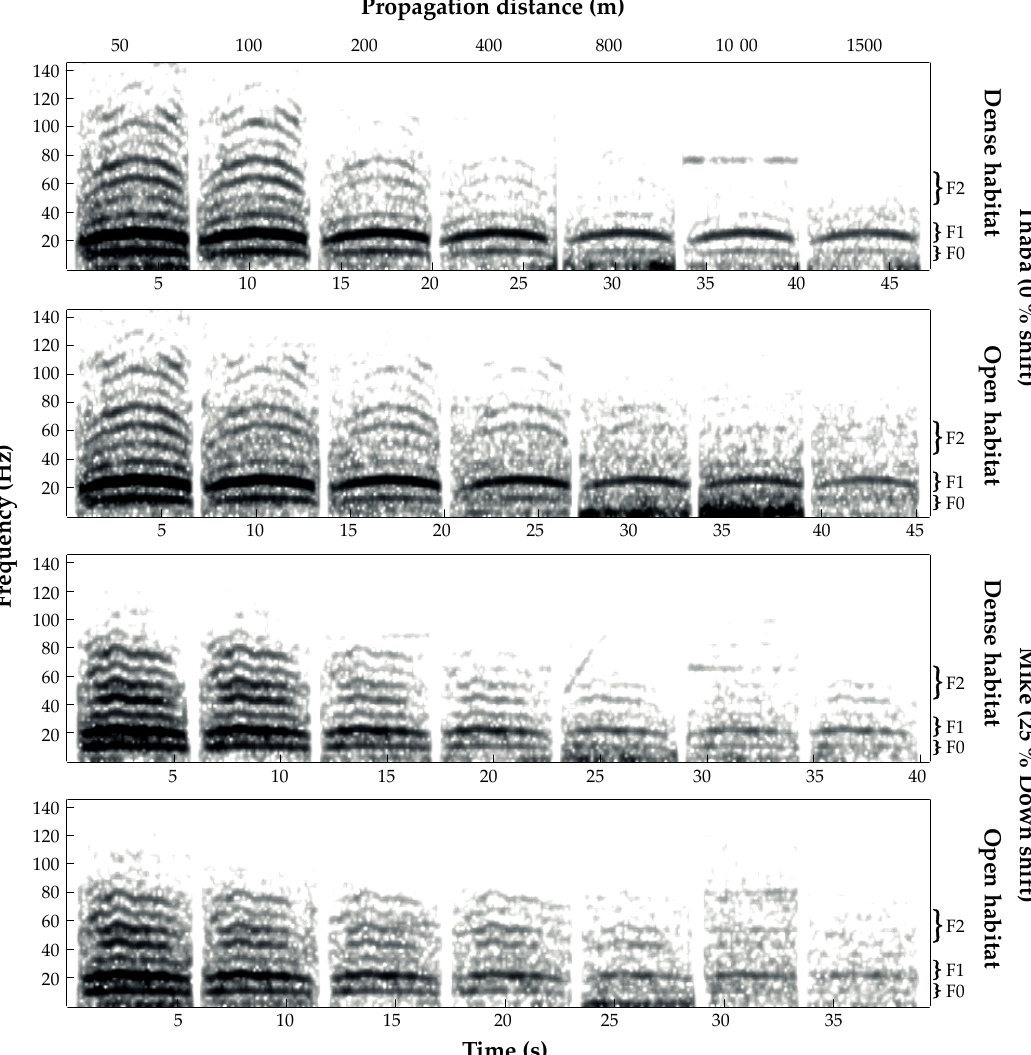
Figure 5. Spectrograms of concatenated 0% (from Thaba) and 25% downshifted (from Mike) re-recordings conducted from 50 to 1500 m for both dense and open habitat, respectively. Curly brackets indicate location for F1 showing the highest transmission consistency, while f o and F2 were less well ‐ defined (S_Tools ‐ STx settings; analysis windows: Kaiser kessel, bandwidth: 2, overlap: 75%).